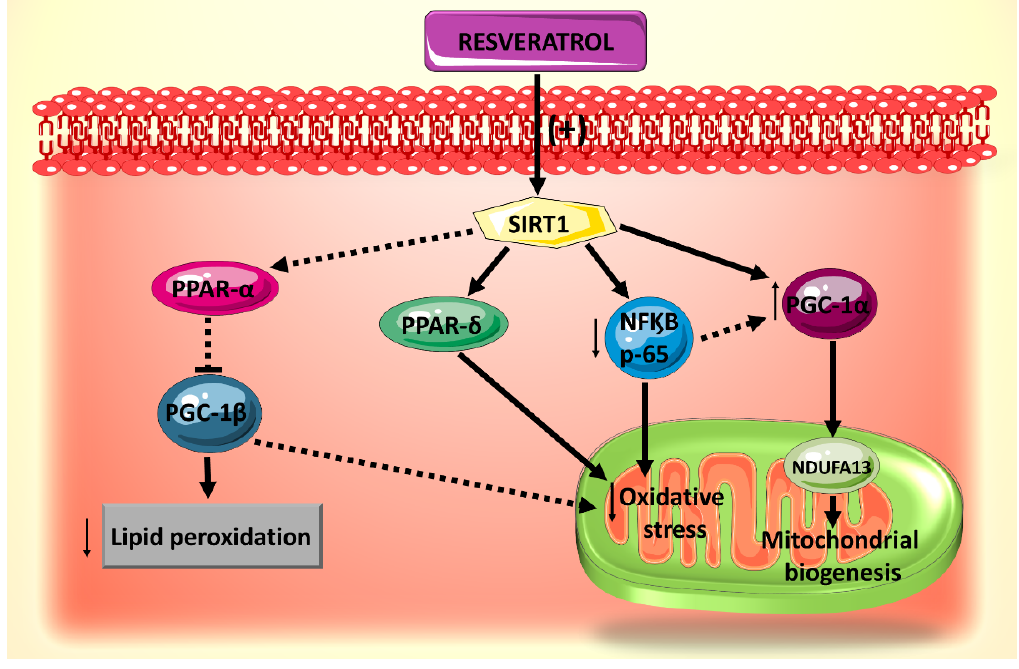
Figure 2. Summary of the effects of resveratrol on mitochondrial biogenesis, oxidative stress and lipid accumulation, all of which are mediated by SIRT1.